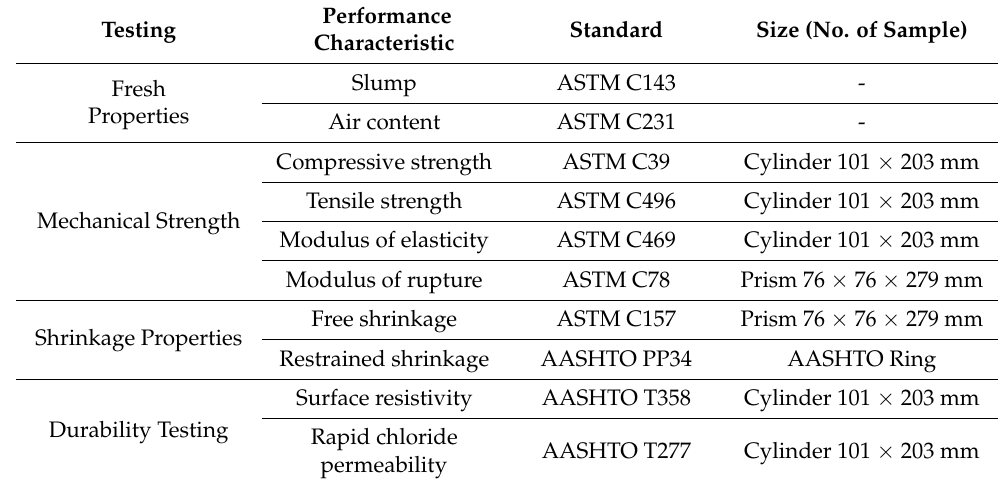
Table 4. Summary of the tests performed for each mix.